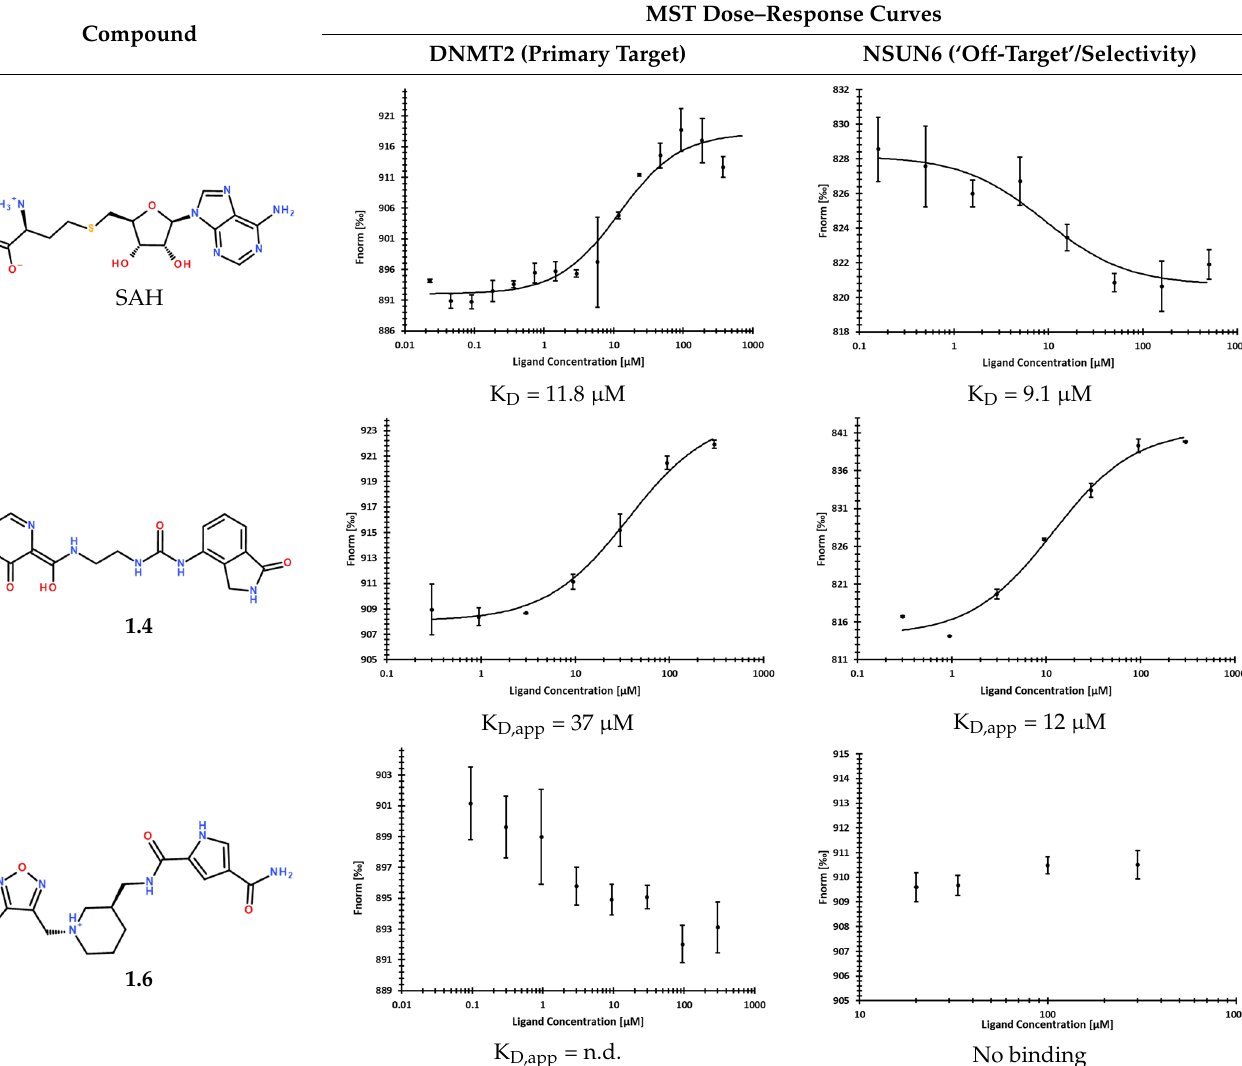
SAH SAH SAH SAH SAH